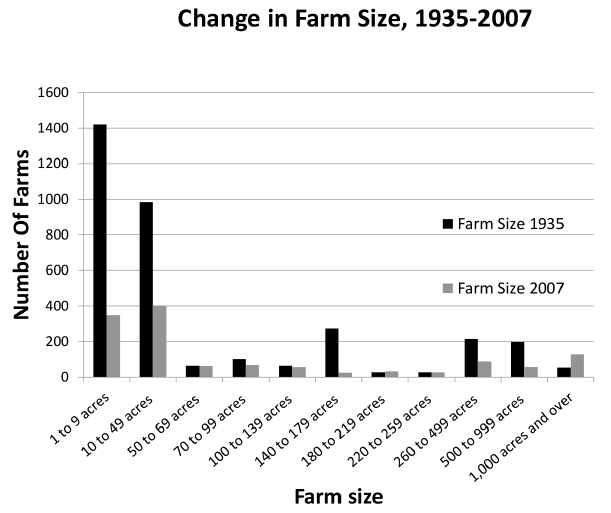
Figure 5. Agricultural parcel size for Rio Arriba County in 1935 and 2007 (NASS, 2012; USDC/USDA, 2014).